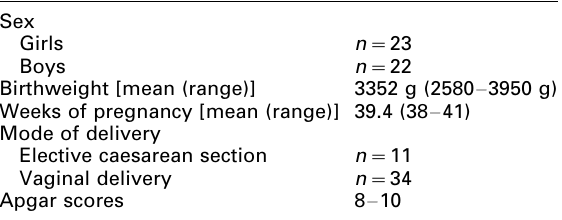
Table 1. Demographic characteristics of